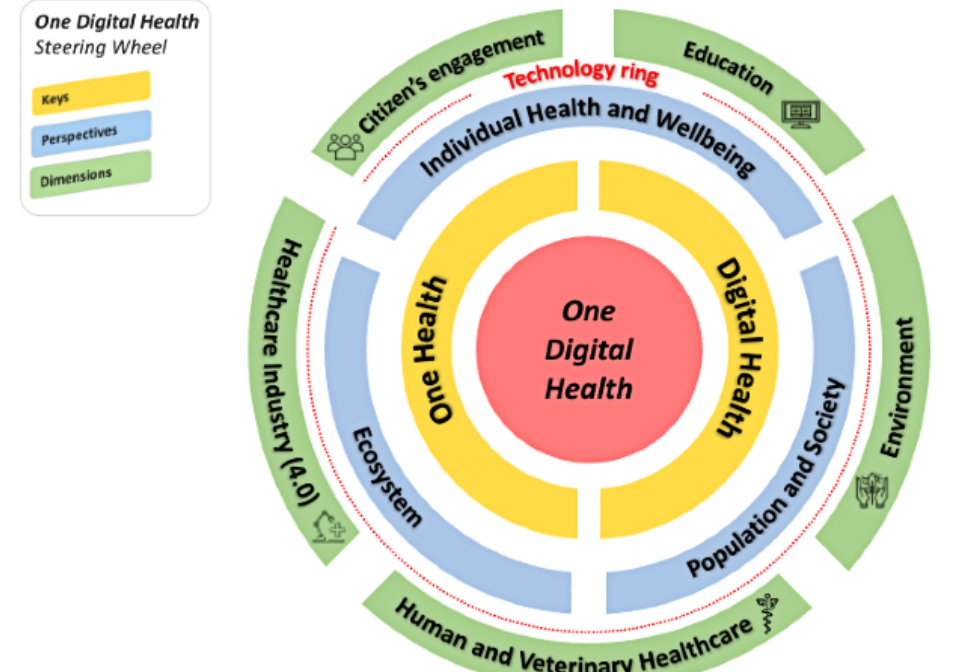
Figure 1. The One Digital Health Steering Wheel conceptual